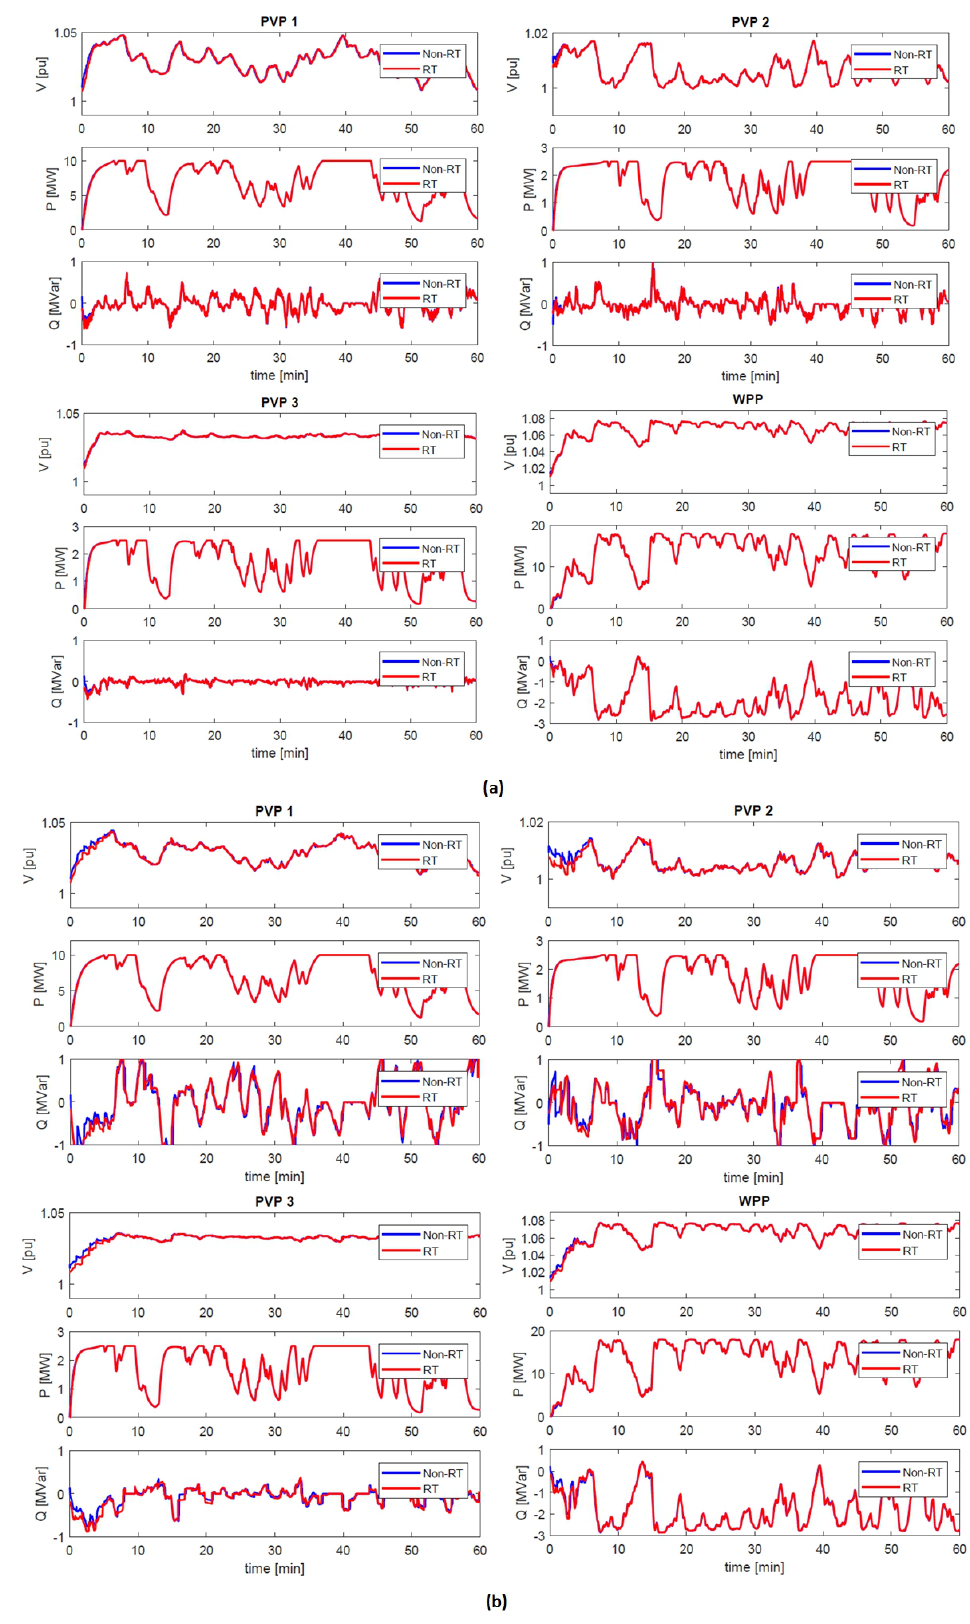
Figure 14. P , Q , V of PVP 1, PVP 2, PVP 3 and WPP over one hour for: ( a ) 10 s update rate; and ( b ) 1 min update